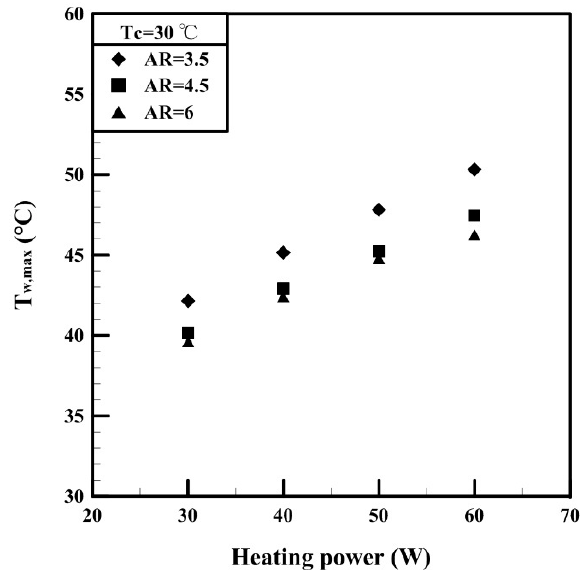
Figure 4. Distribution of the maximum wall temperature.